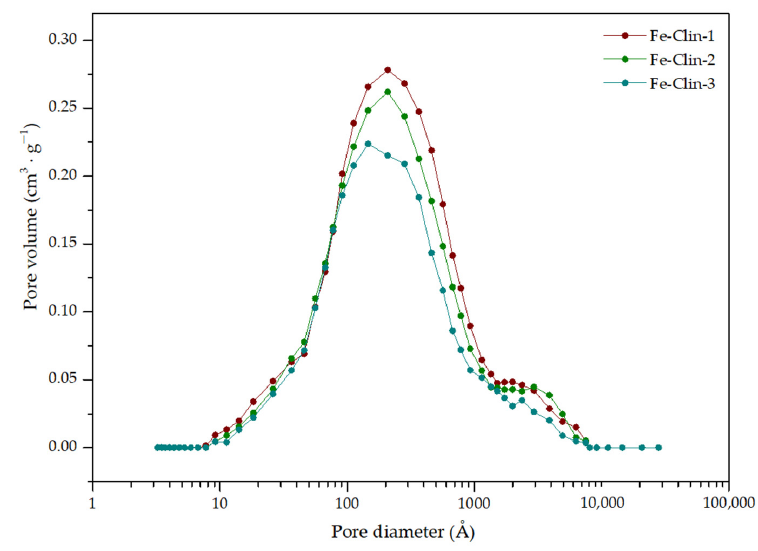
Figure 3. Pore volume obtained for Fe-clinoptilolite catalysts. Table 2. Textural and structural parameters of raw clinoptilolite and the Fe-clinoptilolite catalysts.